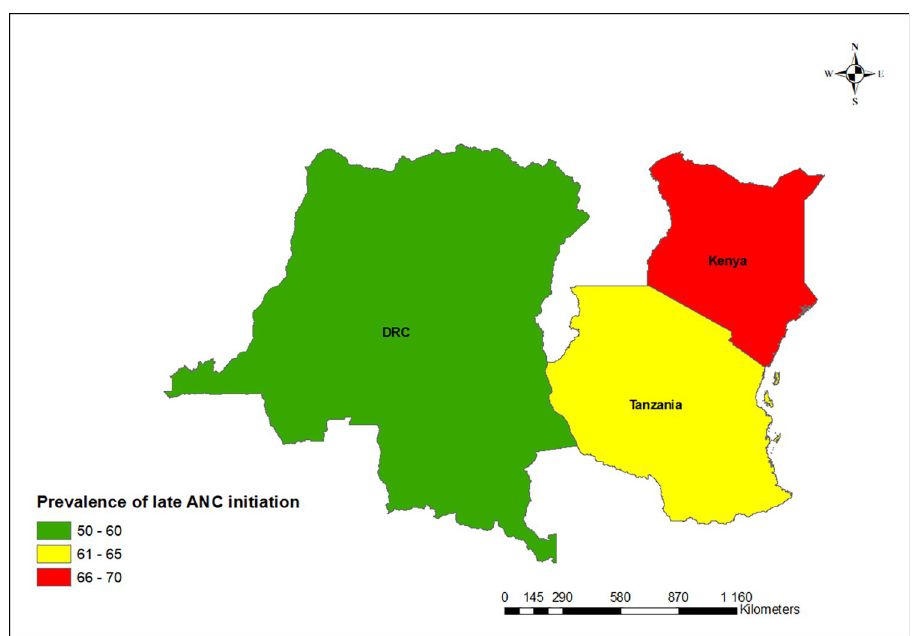
Fig 1. Map showing the prevalence of late ANC initiation in the DRC, Kenya, and Tanzania in the first survey in this study: Base map source at https://spatialdata.dhsprogram.com. https://doi.org/10.1371/journal.pgph.0000534.g001 which dropped from 67.8% to 60.5% between 2008 and 2014. Between 2007 and 2014, the trends showed that the DRC had an increase in late ANC initiation, rising from 56.8% to 61.0% (Fig 3).